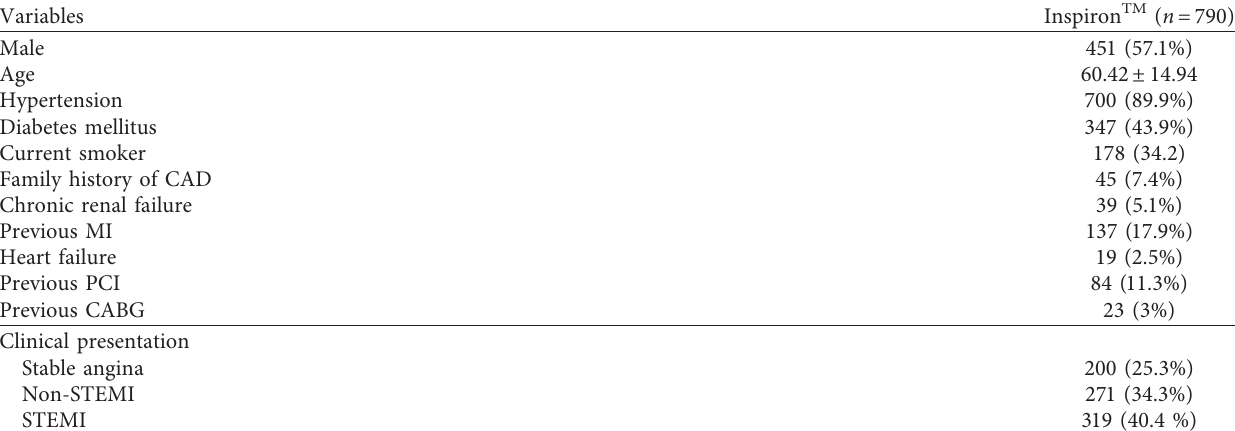
Table 1: Baseline clinical characteristics of patients with the Inspiron TM .